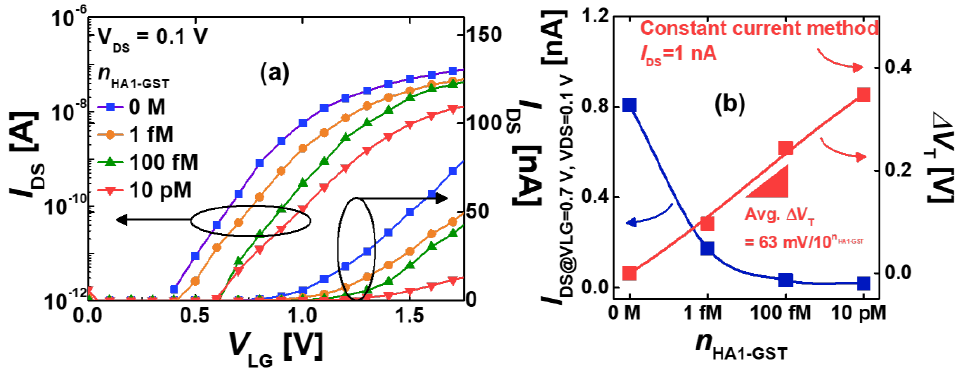
Figure 10. ( a ) Measured transfer curves of the SiNW FETs after APTES / GA / CMP-NANA / HA1-GST immobilization, depending on the concentration of HA1-GST. ( b ) Measured I DS and ∆ V T with various concentrations of HA1-GST.